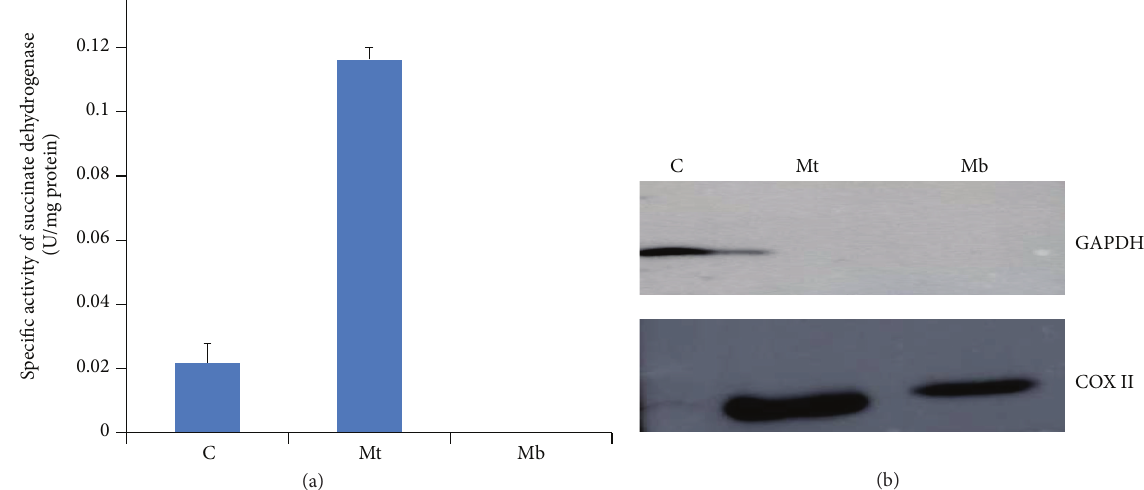
Figure 2: (a) Specific activity analysis of succinate dehydrogenase (SDH). (b) Western blot analysis of cytosolic GAPDH and mitochondrial COX II in C = cytosol, Mt = mitochondrial, and Mb = mitochondrial membrane-bound fraction.